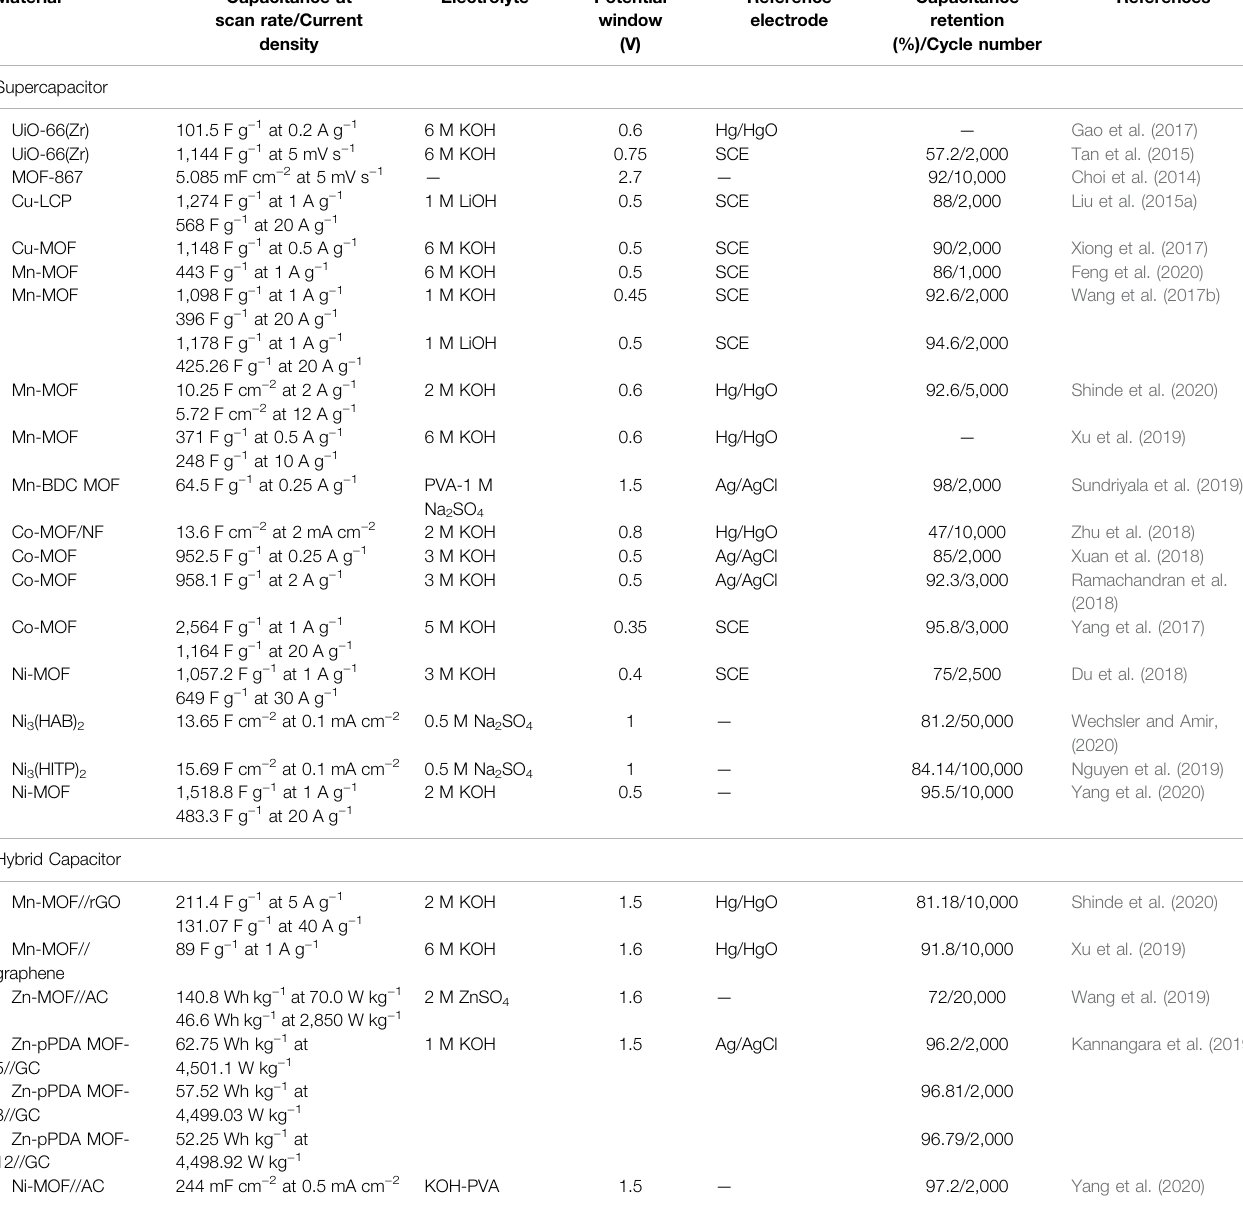
TABLE 1 | The summary of the electrochemical performance of pristine MOFs materials utilized as SCs electrode materials.